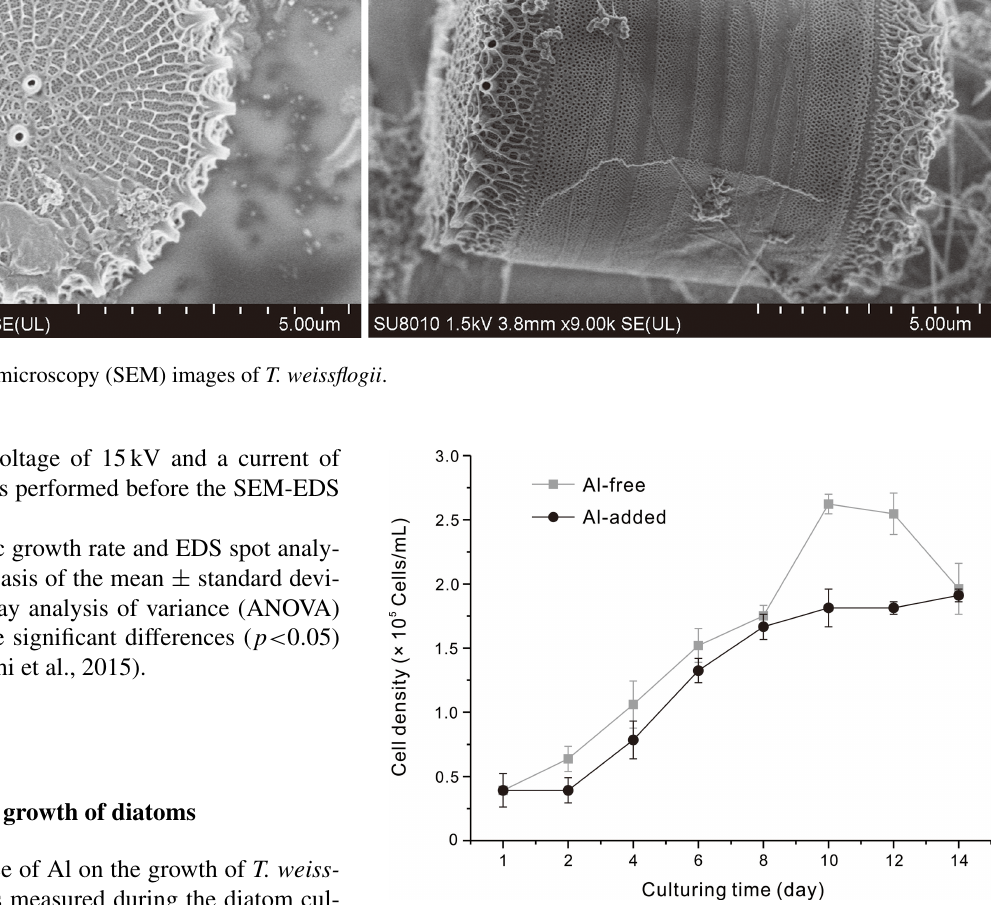
Figure 3. The cell densities of the diatoms cultured in culture medi- ums with (Al-added) and without (Al-free) the addition of Al during the 14d culturing